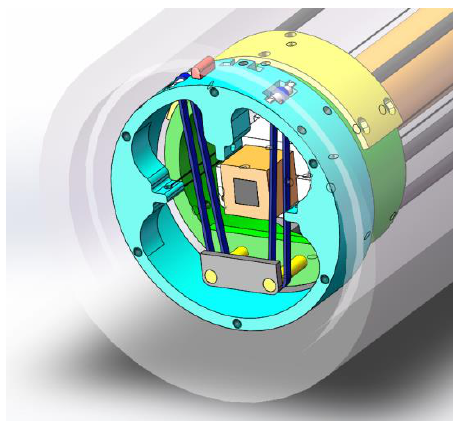
Figure 7. The overall structure model of the antenna damping system.